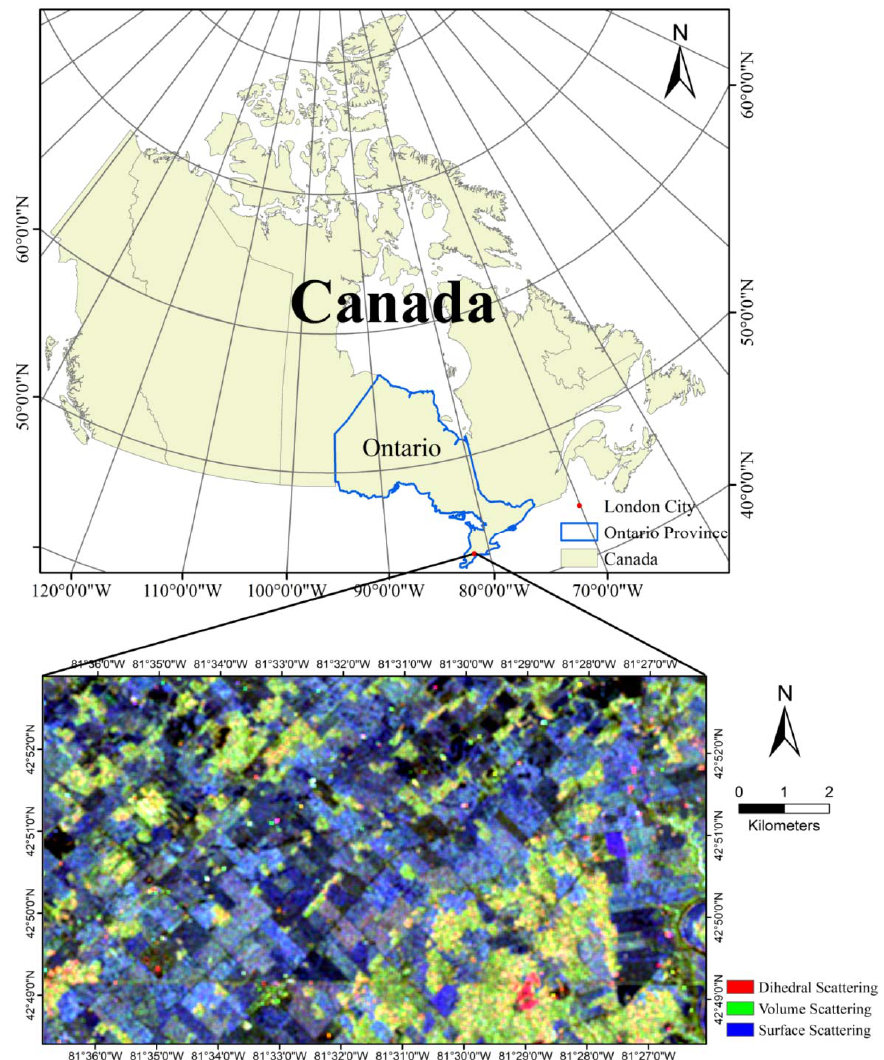
Figure 1. Location and Pauli RGB image acquired on 12 April 2015 of the study site.